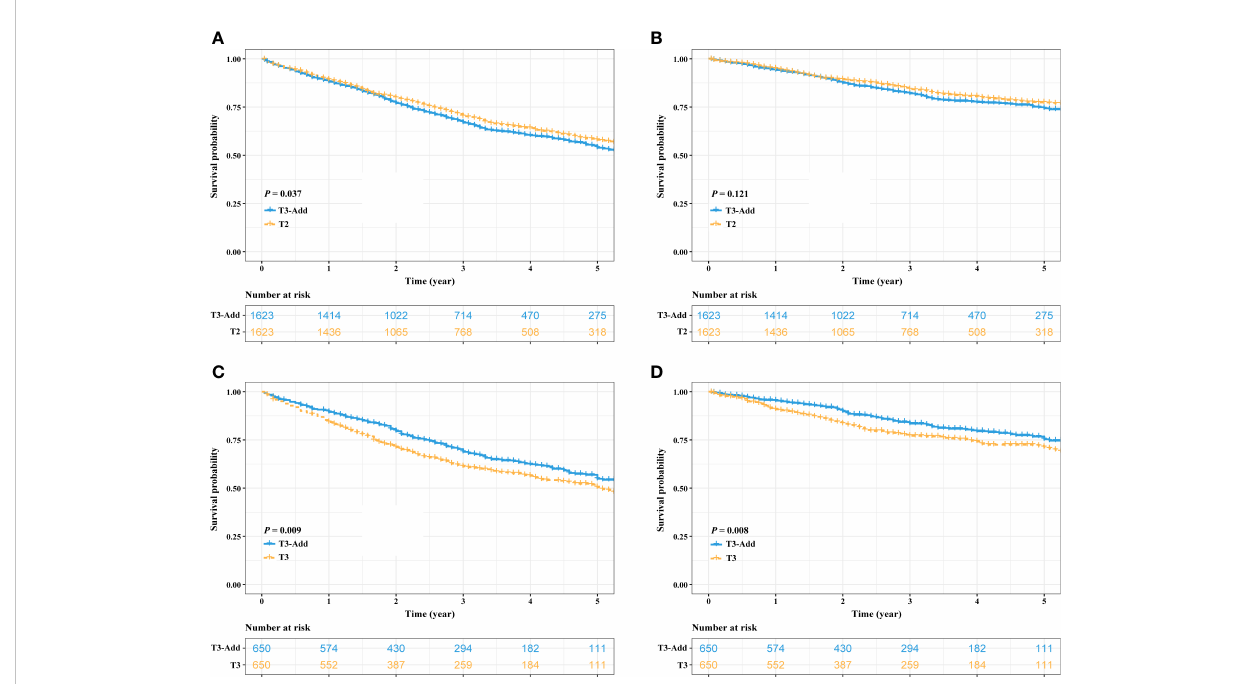
FIGURE 3 Kaplan – Meier estimates of survivals in the T3-Add & T2 pair and the T3-Add & T3 pair after PSM. (A) overall survival: T3-Add vs. T2; (B) cancer speci fi c survival: T3-Add vs. T2; (C) overall survival: T3-Add vs. T3; (D) cancer speci fi c survival: T3-Add vs. T3. PSM, propensity score matching; T3- Add, T3 non-small cell lung cancer with additional tumor nodules in the same lobe.